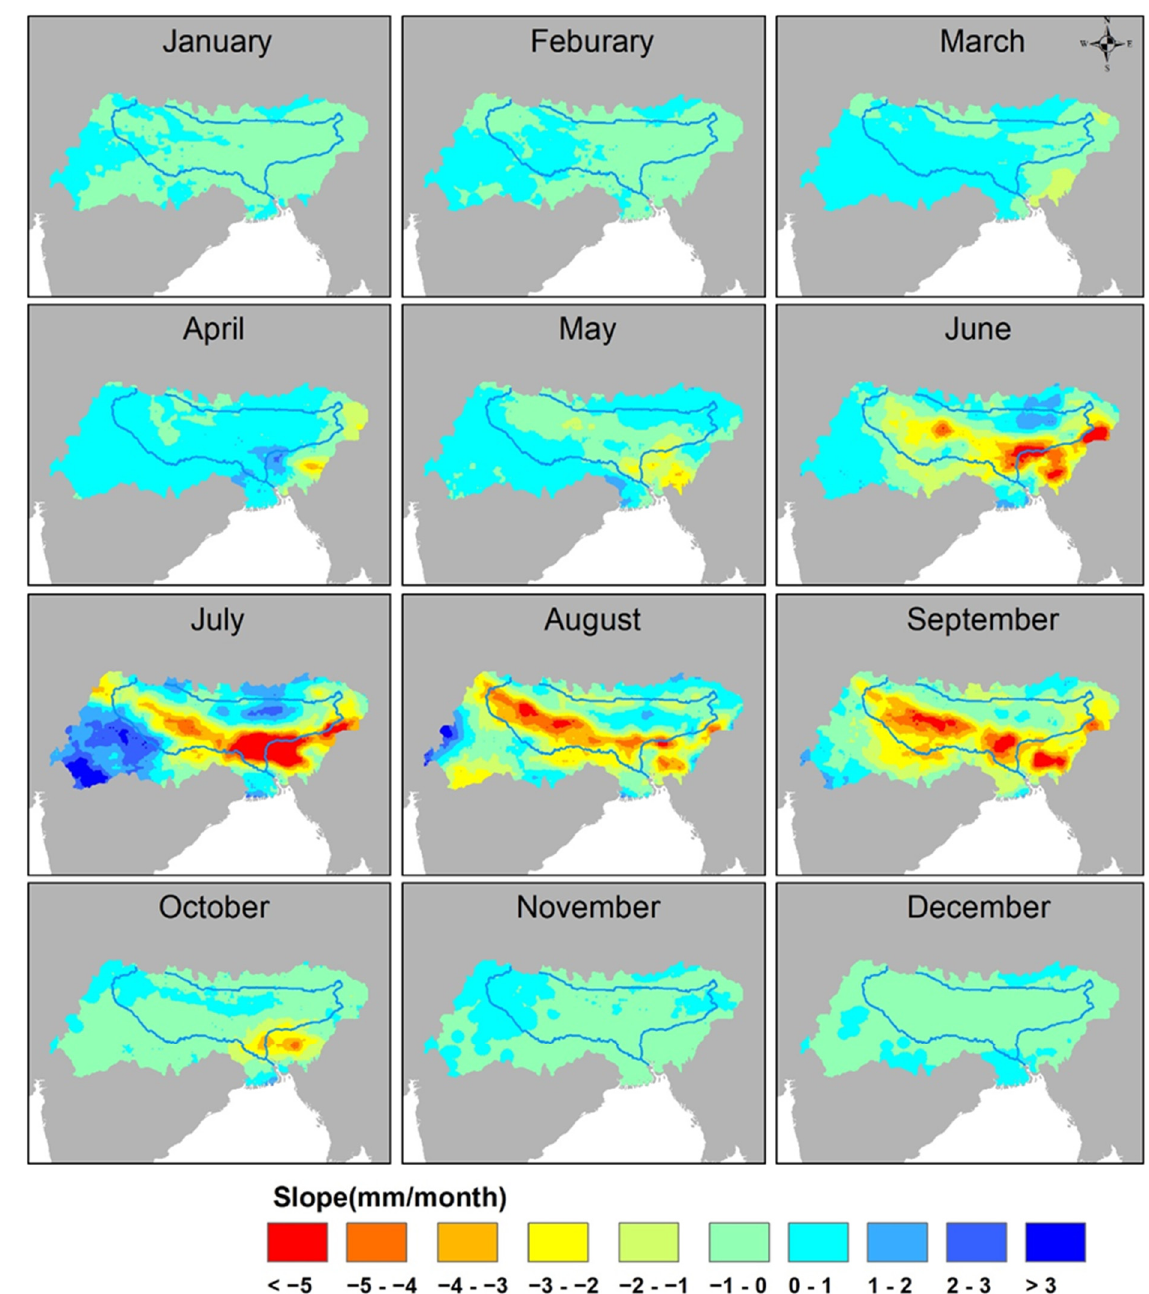
Figure 5. Monthly precipitation trends across the Ganga–Brahmaputra Basin.